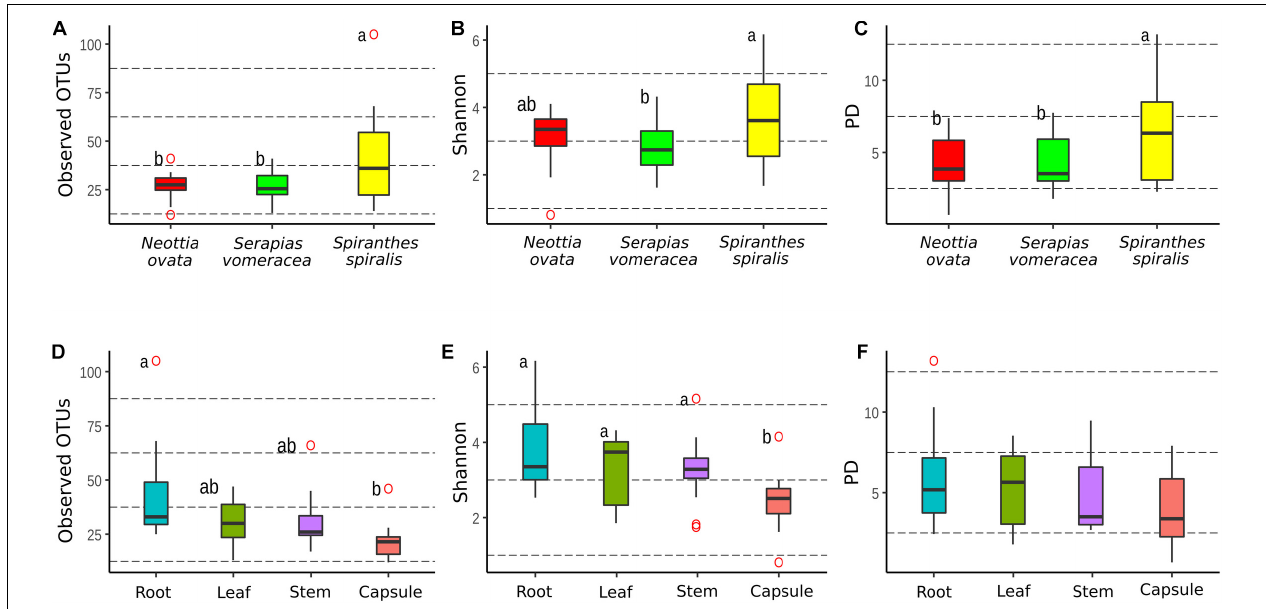
FIGURE 4 | Comparison of alpha-diversity metrics between the microbiota of three Mediterranean orchid species. Richness (observed OTUs), diversity (Shannon) and phylogenetic diversity (PD) for different orchid species (A–C) and organs (D–F) . ◦ indicates outliers. Different letters above the bars indicate significantly different means (Tukey test, p < 0.05); no letters ( panel F) indicate no statistically significant differences.